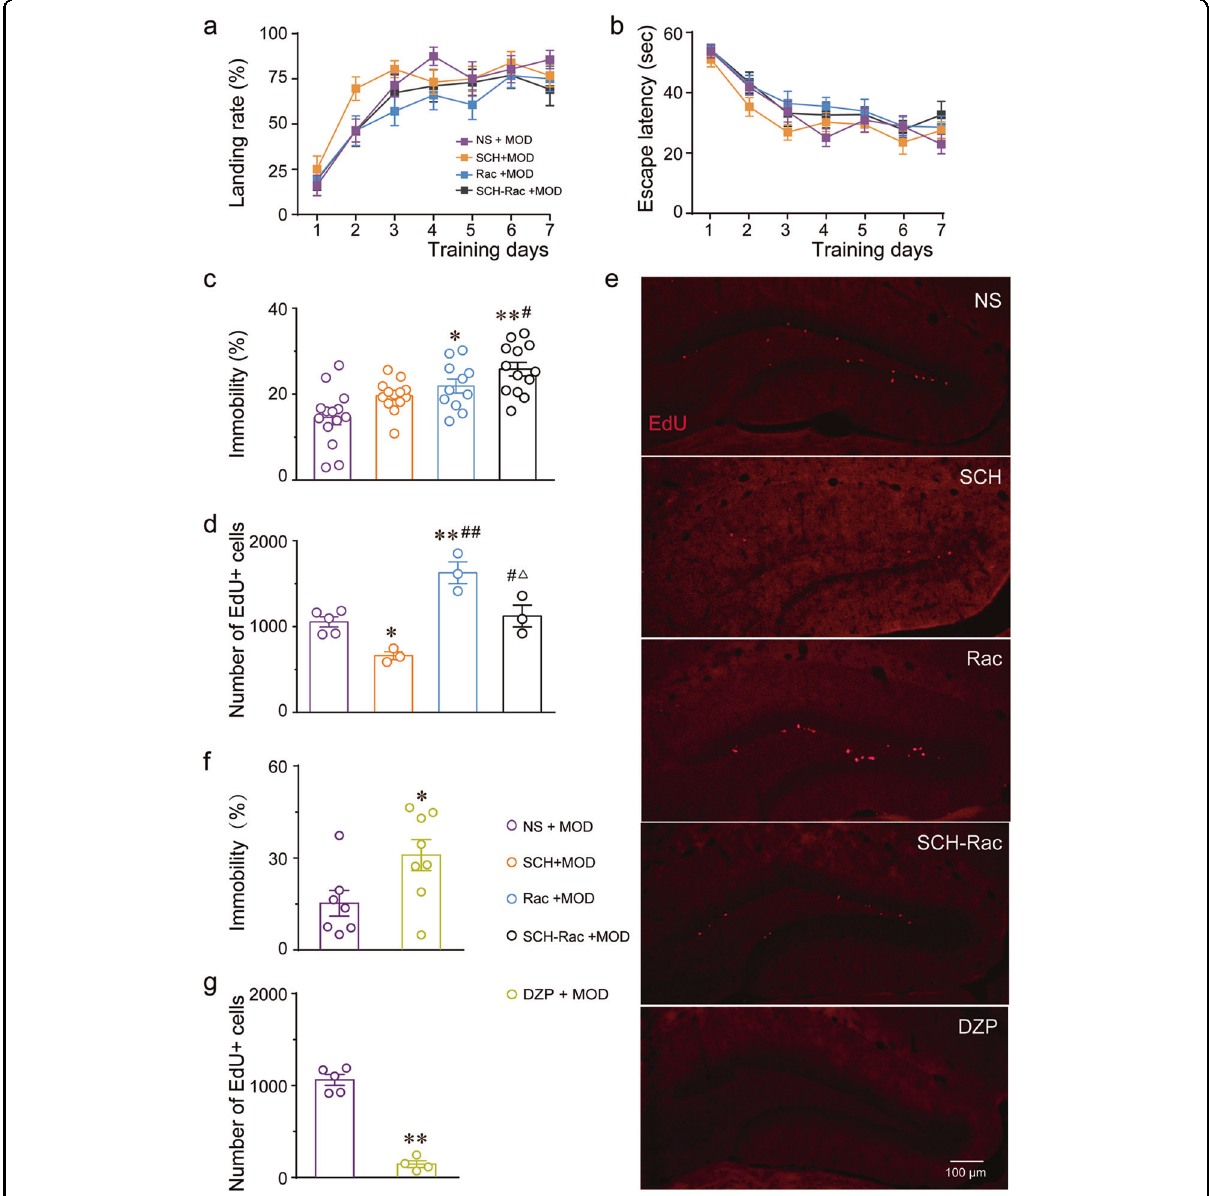
Fig. 5 Dopamine and GABA A receptors mediate MOD-produced anti-depressant effects and hippocampal neurogenesis-promotion in ovariectomized mice. a – d In ovariectomized mice treated with moda fi nil (MOD) at 45 mg/kg in the presence of saline (NS), a selective D 1 receptor antagonist SCH23390 (SCH), a selective D 2 receptor antagonist raclopride (Rac), and combined use of SCH and Rac, respectively, the landing rates ( a ) and escape latencies ( b ) locating the invisible platform during the seven training days in the Morris water-maze test (NS, SCH, Rac: n = 14 per group; SCH – Rac: n = 13), percentage of immobility time in the forced swimming test (FST) ( c ) (NS: n = 14; SCH, SCH – Rac: n = 13 per group; Rac: n = 11), and the numbers of newborn hippocampal neurons ( d ) (NS: n = 5; SCH, Rac, and SCH-Rac: n = 3 per group). e Representative images of EdU staining in the hippocampal dentate gyrus in each group of mice with ovariectomy (OVX). f , g In OVX mice treated with MOD in the presence of NS or a selective GABA A receptor agonist diazepam (DZP), the percentage of immobility time in the FST ( f ) (NS: n = 7; DZP: n = 8) and the numbers of newborn hippocampal neurons ( g ) (NS: n = 5; DZP: n = 4). * p < 0.05, ** p < 0.01 versus NS group; # p < 0.05, ## p < 0.01 versus SCH group; △ p < 0.05 versus Rac group. EdU 5-ethynyl-2 ′